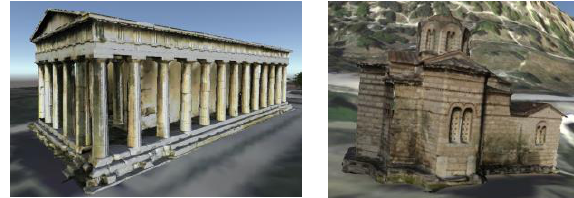
Figure 13: Temple of Hephaestus (left) and Holy Apostles church (right) with the right texture